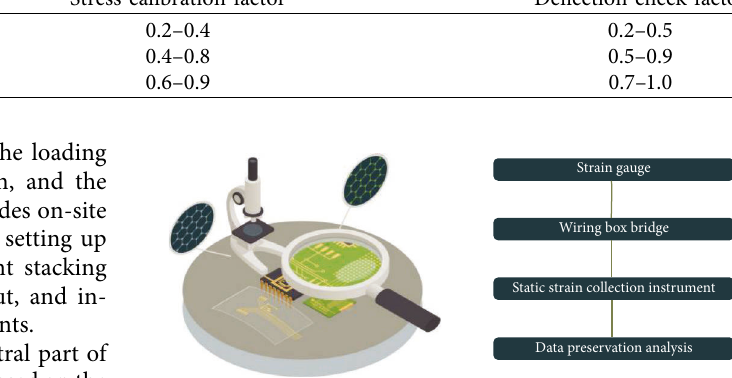
Figure 1: Schematic diagram of the site layout of static load test data collection.